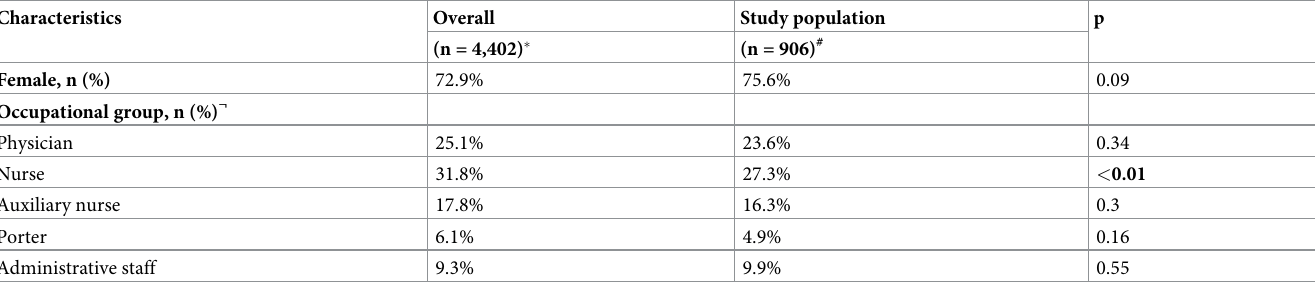
Table 1. Description of hospital workers included in the study vs. overall